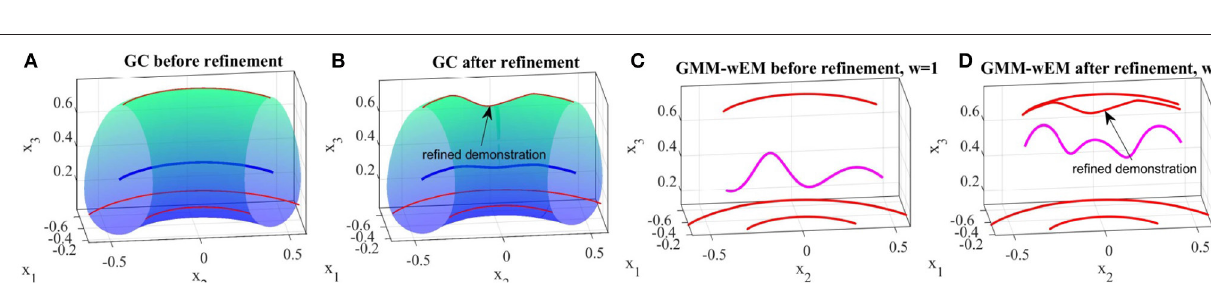
FIGURE 17 | Comparing incremental skill refinement on the first experiment in section 6.1. (A,B) results using TLGC, (C,D) results using